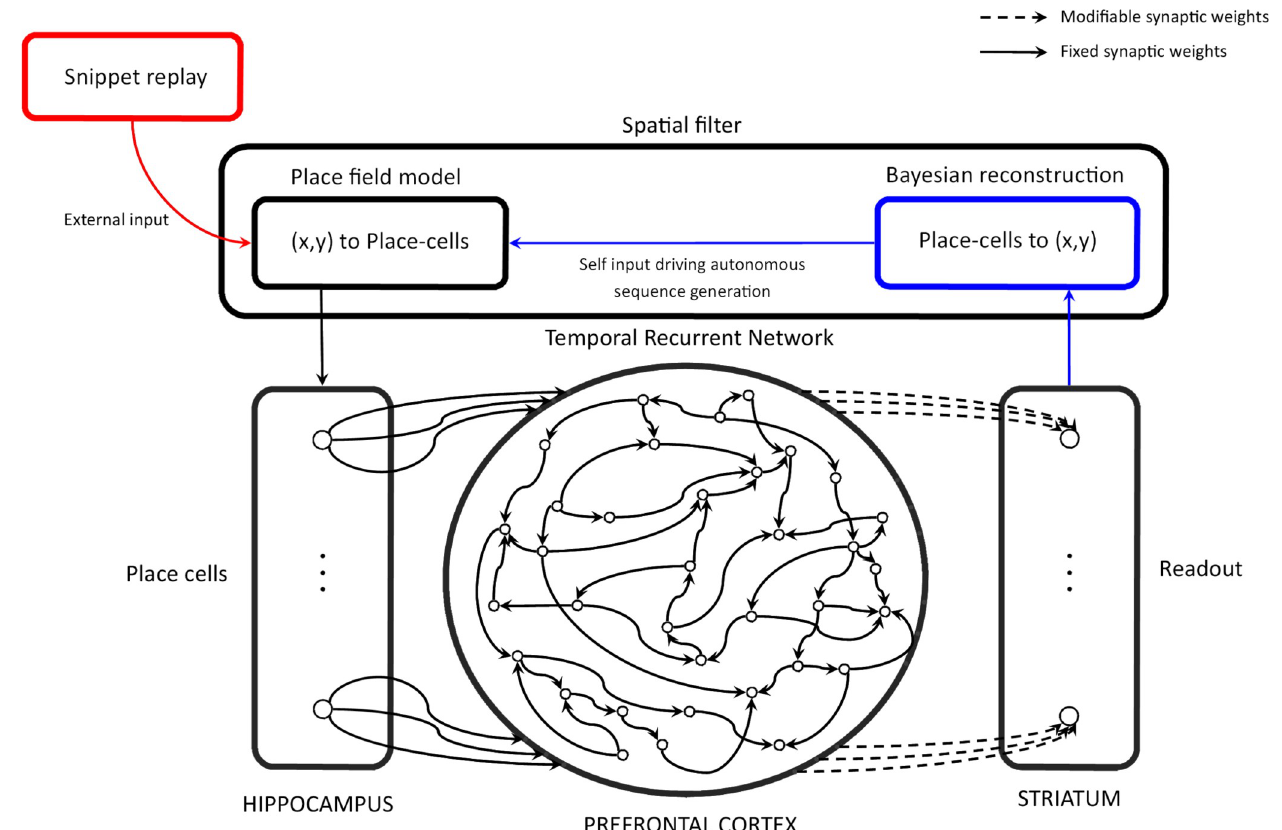
Fig 3. Reservoir computing model. The Temporal Recurrent Network (TRN) is a model of the prefrontal cortex (PFC) that takes into account cortico- cortical loops by defining a fixed recurrent adjacency matrix for the leaky integrator neurons that model PFC neurons. Inputs of the TRN are modelled hippocampus (HIPP) place-cells. During the training phase, place-cells activations are provided by the algorithmic model of SWR replay (red pathway), and the striatum model learns to predict the next place-cell activation from the PFC model states by modifying the synaptic weights that project the PFC model into the striatum model according to the delta learning rule. During the generation phase, the model is no longer learning and the place-cell activation patterns result from the new position of the agent, reconstructed with a Bayesian algorithm from the next place-cell activation prediction of the modeled striatum (blue